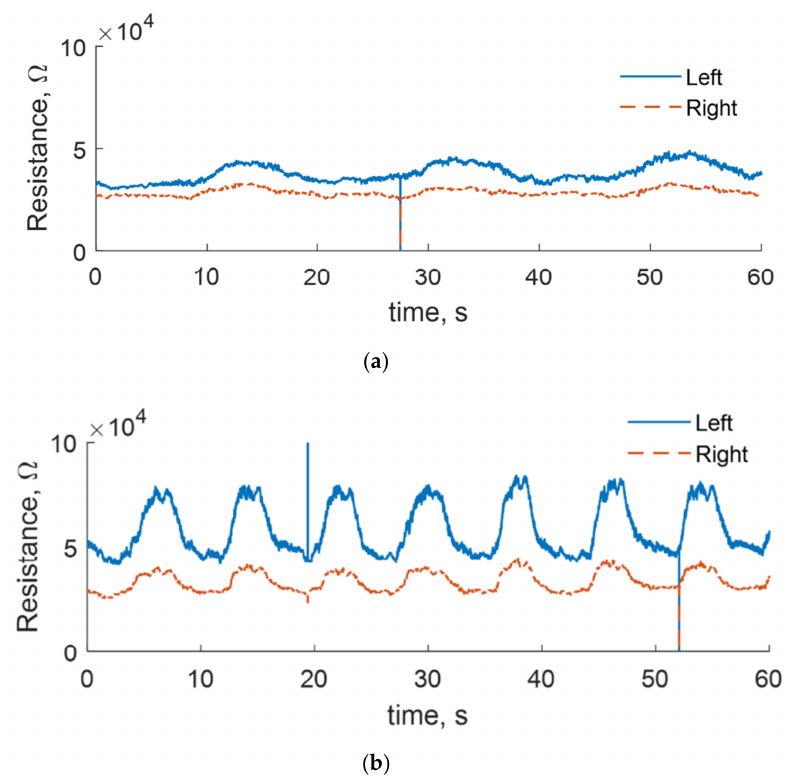
Figure 5. A raw measurement of the shoulder movement with the DAid shirt system for bilateral arm lift exercise. Comparison between the sensor reading for ( a ) a correct (slow, controlled) movement and ( b ) an incorrect, relatively fast movement with no control over the shoulder position. A considerably lower amplitude change during a controlled motion indicates less shoulder motion during the